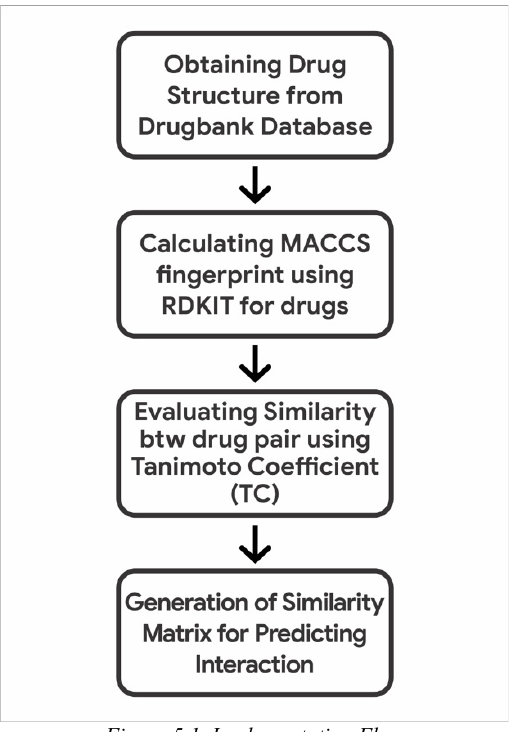
Figure 5.1. Implementation Flow